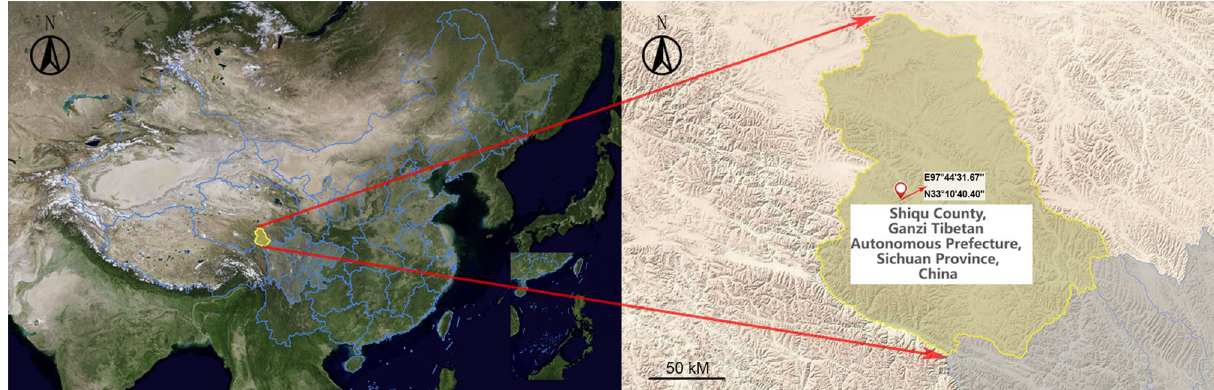
Figure 1. Satellite map (left) and topographic map (right) of the rodent collection area on the eastern Tibetan Plateau of China. Shiqu county is highlighted yellow, and Sichuan province is marked in light gray, the geographic coordinate of collection site (E97°44 ′ 3E.67", N33°10 ′ 40.40") is marked on the topographic map. The map was generated by SuperMap (http:// www. super mapol.